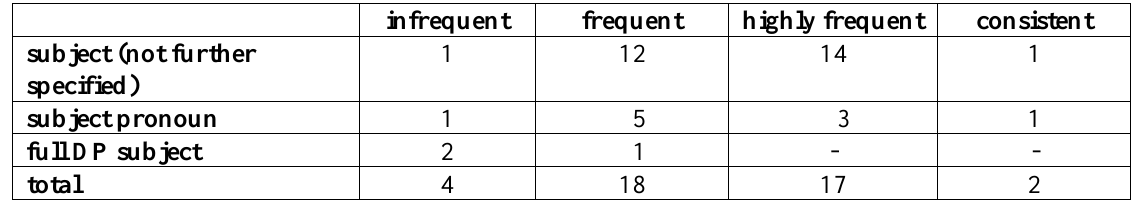
Table (1): Frequencies of wh SV order in varieties of Caribbean Spanish as reported in a multitude of pieces of research